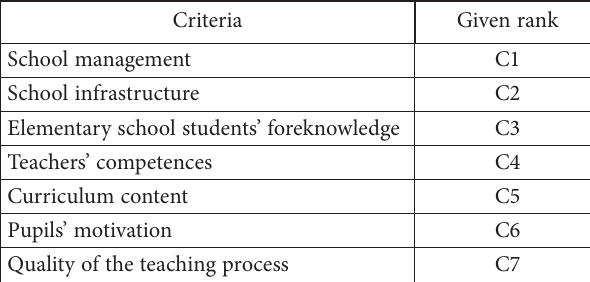
Table 1. Examined criteria Criteria Given